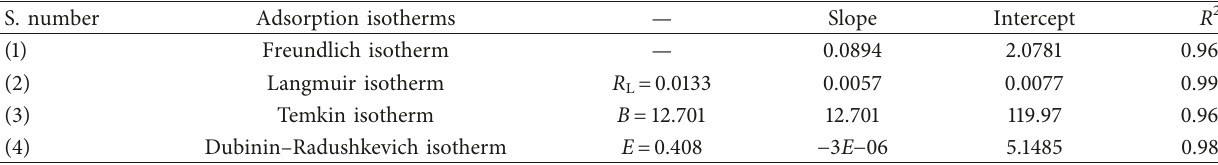
Table 3: Adsorption parameters.